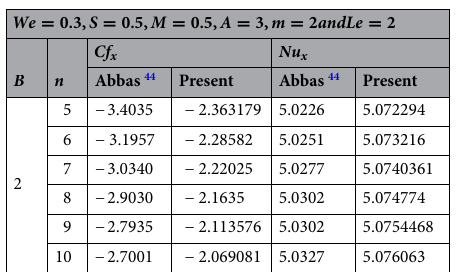
Table 4. Comparison of present outcomes of Nusselt number and skin friction with already published results by Abbas 44